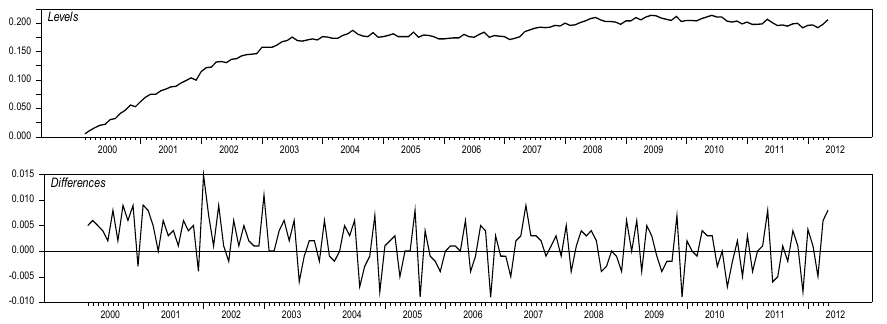
Figure 11. Slovenian consumer price index I ( 1 ) . Data vector January 2000 to May 2012 (Great Depression).